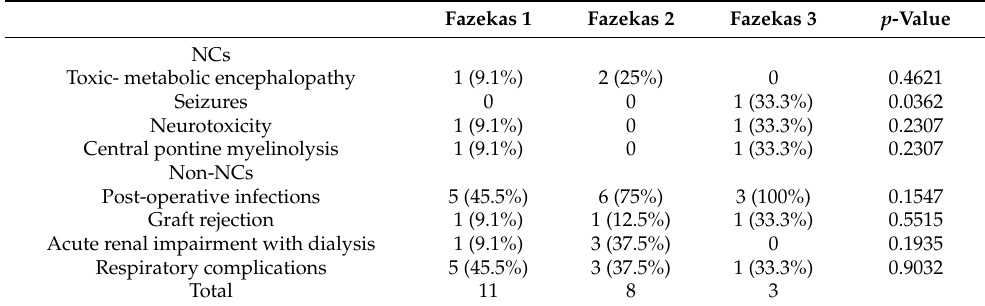
Table 5. Neurological and Non-Neurological Complications distribution in different Fazekas scale